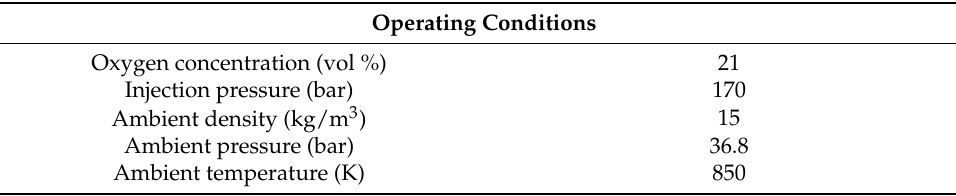
Table 1. Operating conditions